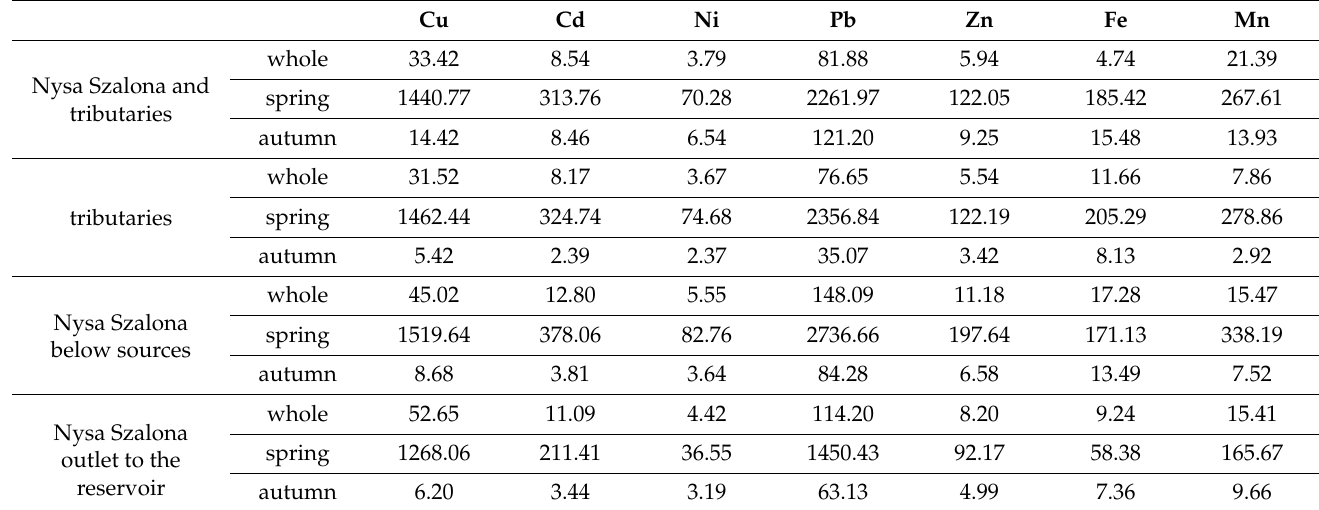
Table 14. Enrichment factor (EF) in reed canary grass from the Nysa Szalona